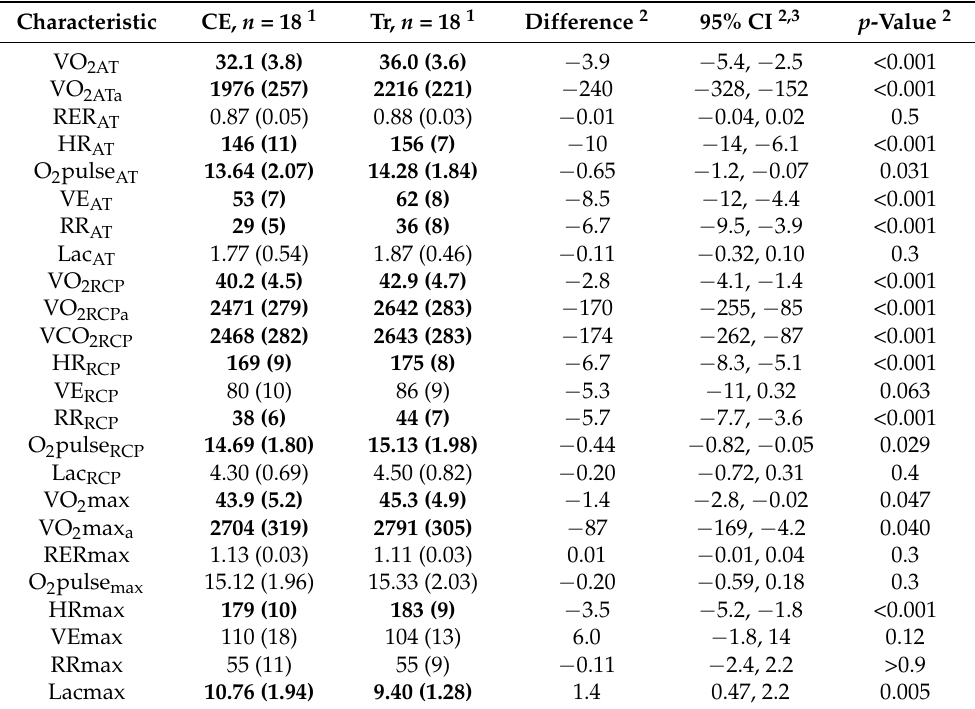
Table 3. Differences between cycle ergometry (CE) and treadmill (Tr) CPET results in female partici- pants; significant results are bold.